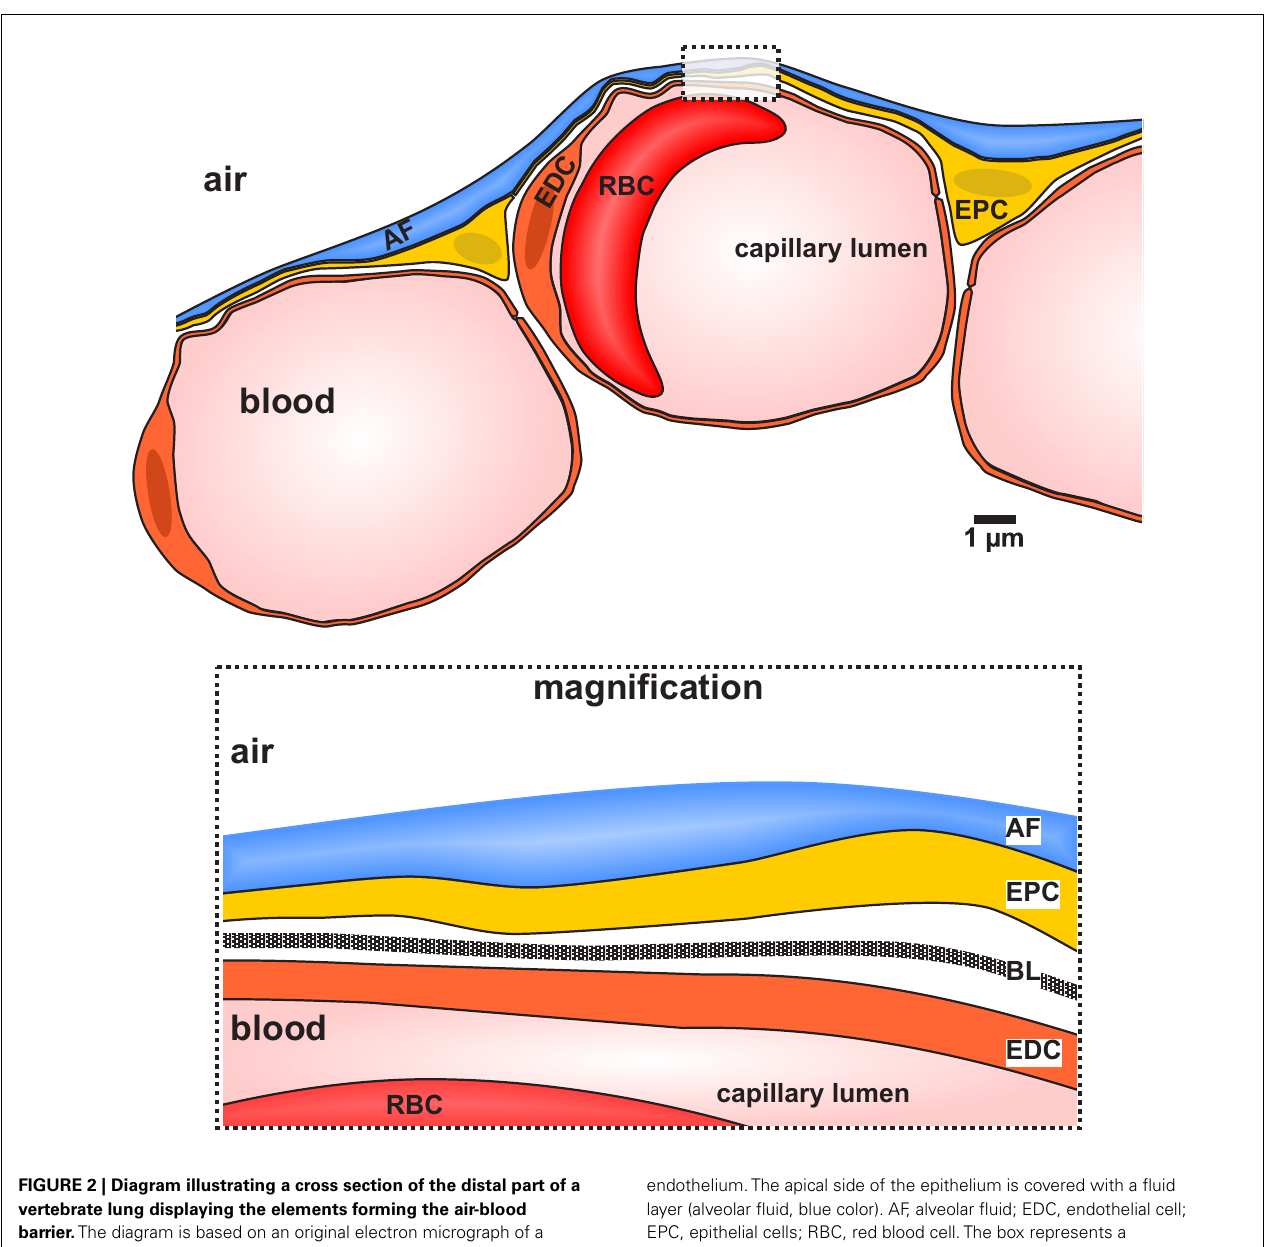
FIGURE 2 | Diagram illustrating a cross section of the distal part of a vertebrate lung displaying the elements forming the air-blood barrier. The diagram is based on an original electron micrograph of a cross section of a lung of Xenopus laevis (Fischer et al., 1989).The Air-blood barrier is formed by the epithelium, the basal lamina, and the